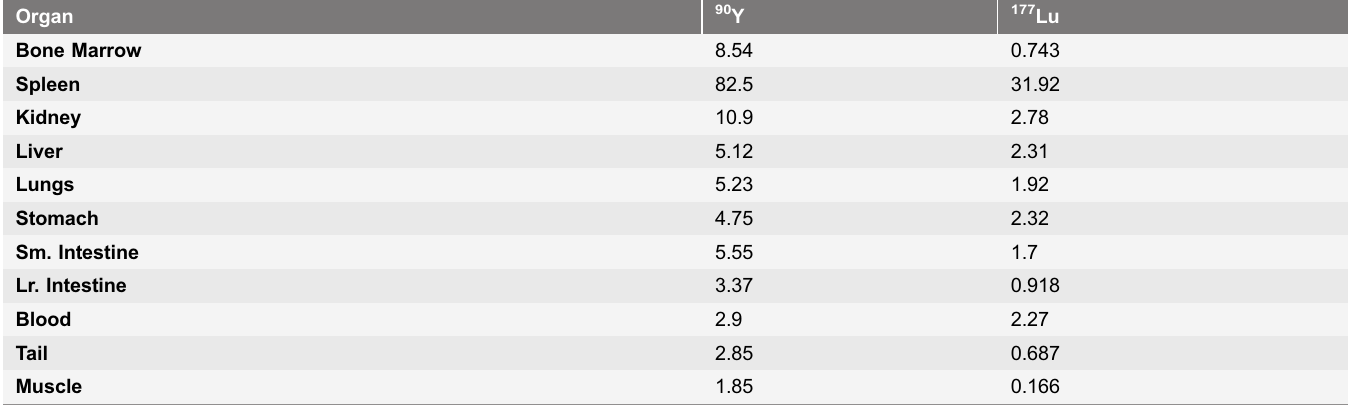
Table 1. Calculated absorbed dose (cGy)/ m Ci